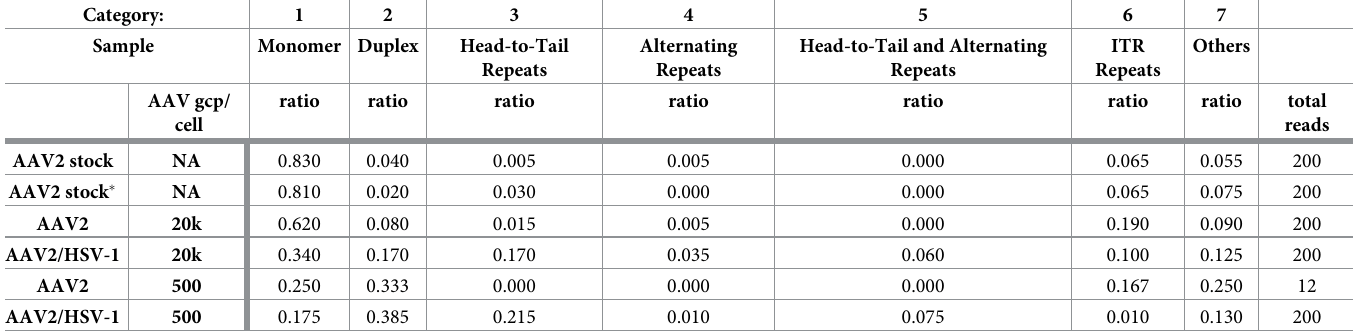
Table 1. Read analysis data from genomes isolated from purified AAV2 virus stock or AAV2 single- or HSV-1 co-infected BJ cells at 12 hpi. � Without Phe/CHCl 3 - purification before sequencing.